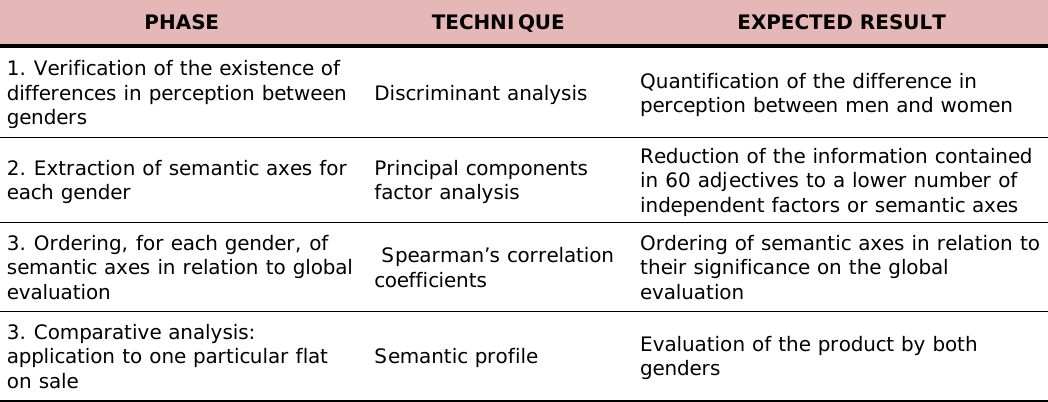
Table 1. “Data treatment phases, techniques and expected results”. Source: